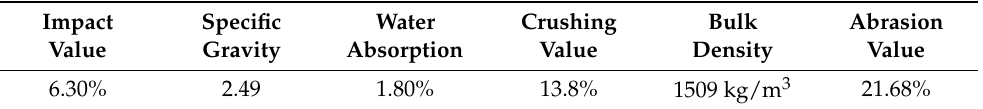
Table 5. Properties of Jhelum